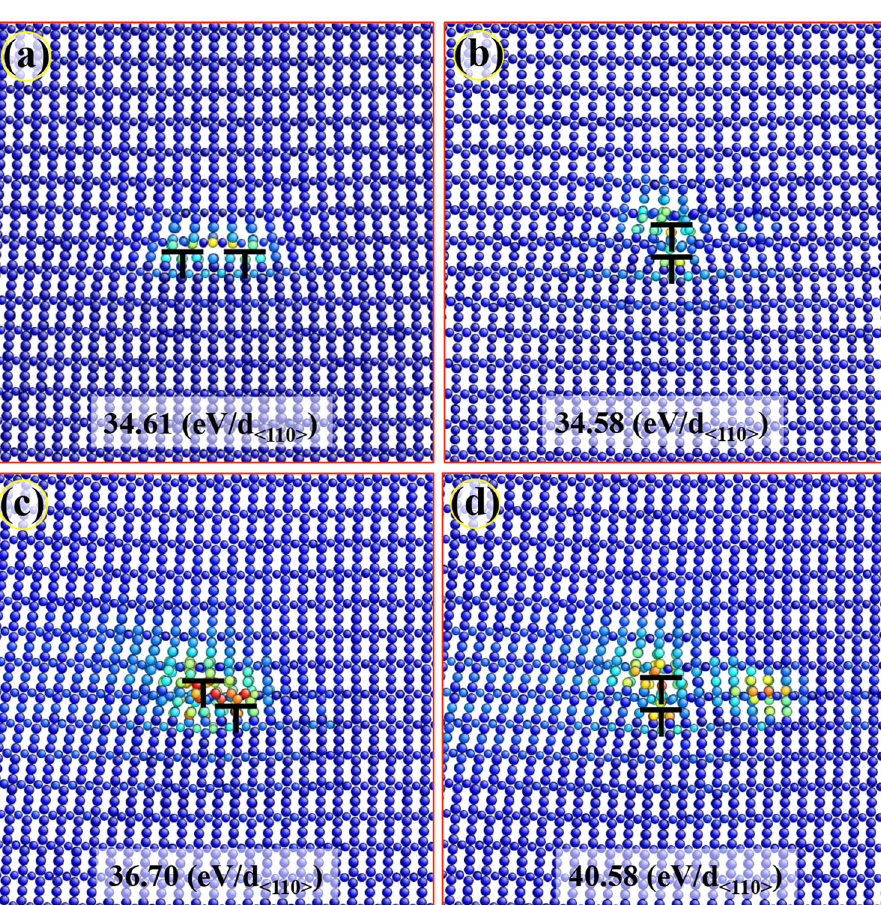
Fig. 5 Atomic structures of two partials a with an extended planar core, b with a vertical core, c with a vertical core surrounded by six vacancies, and d with a vertical core and six vacancies away from the core. The symbol “ ⊥ ” indicates the position of dislocation. The symbol “ ⊥ ” indicates the position of